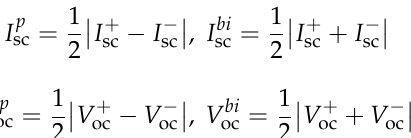
Table 4. A summary of results achieved for photovoltaic devices based on low dimensional ferroelectrics 1 .